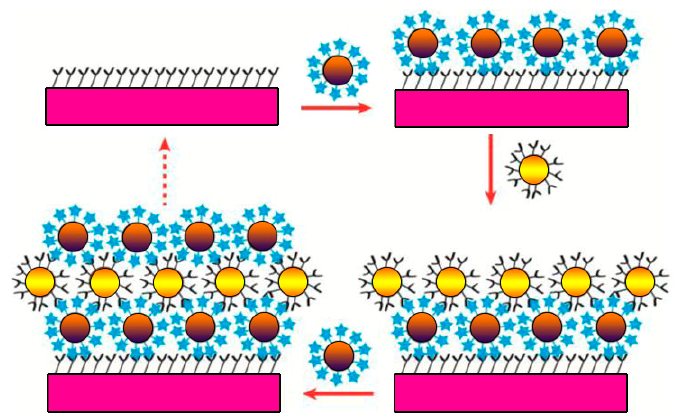
Figure 3. Illustration of the few layers nanoparticle deposition method. Reproduced from [96], Elsevier: